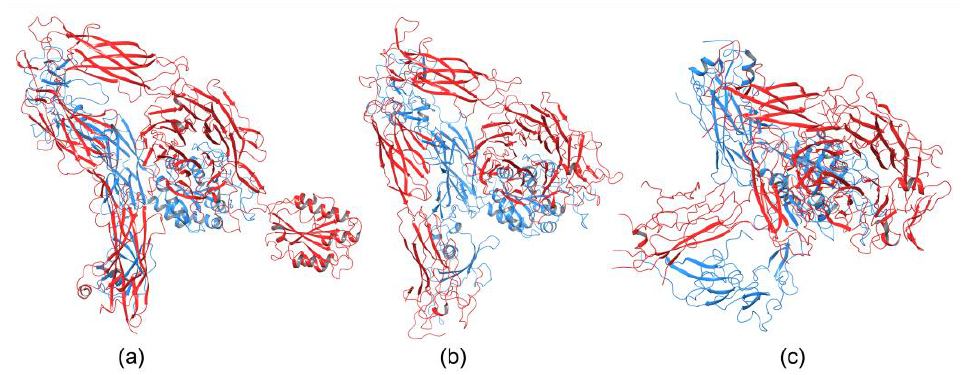
Figure 4. Crystal structures of integrin ( a ) containing α I domain (4NEH) in metastable state and integrins lacking the α I domain ( b ) α v β 3 (3IJE) and ( c ) α IIb β 3 (4CAK) in the bent